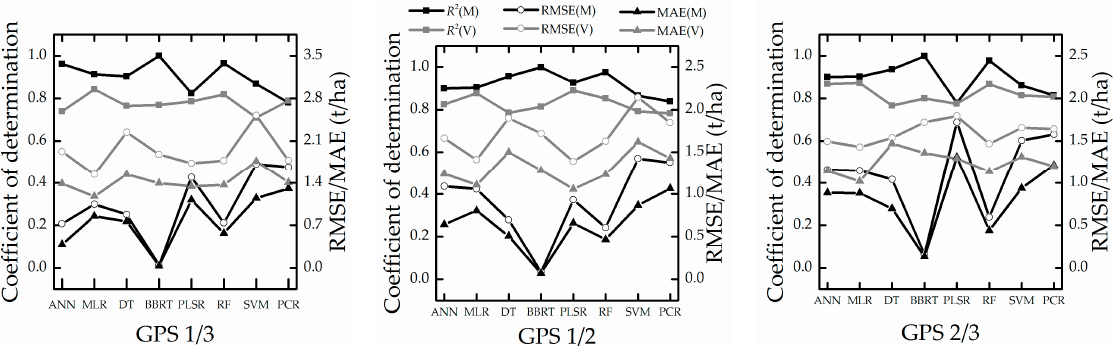
Figure 9. Modeling and validation results for growth period sampling (GPS). Table 7. Absolute difference AGB − GPS between modeling and validation accuracy.